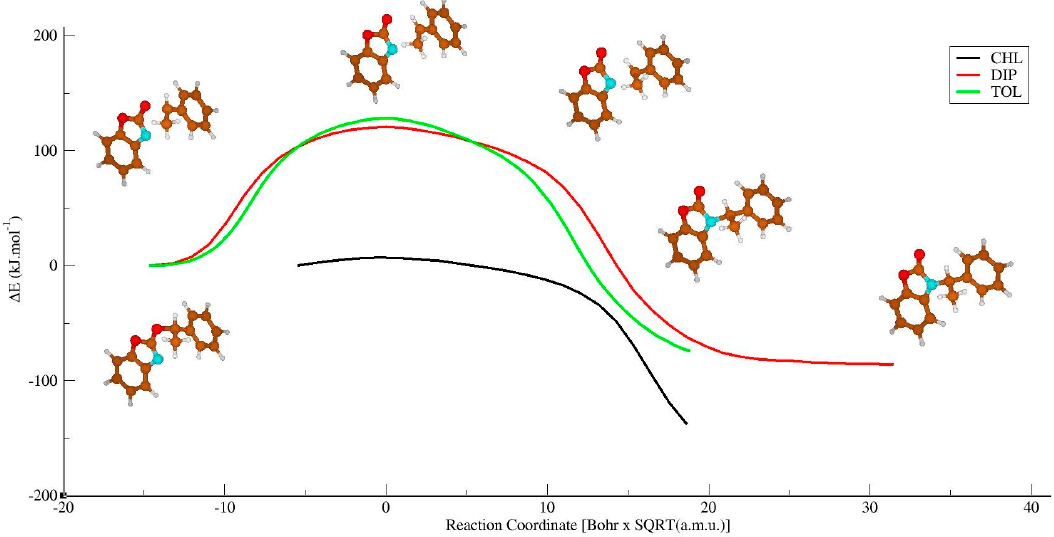
Figure 1. IRC analysis for the solvents toluene, chloroform and diisopropylether.